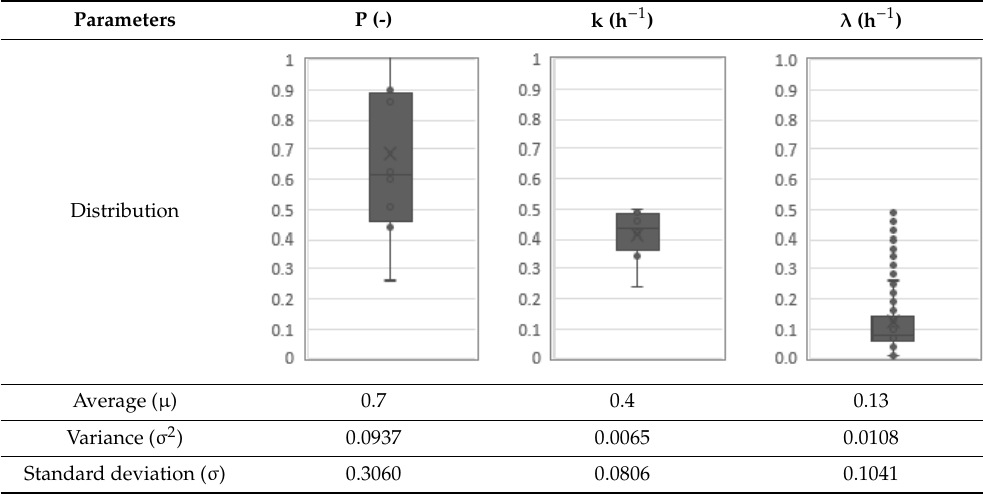
Table 1. Results of P, k, and λ obtained from tests.